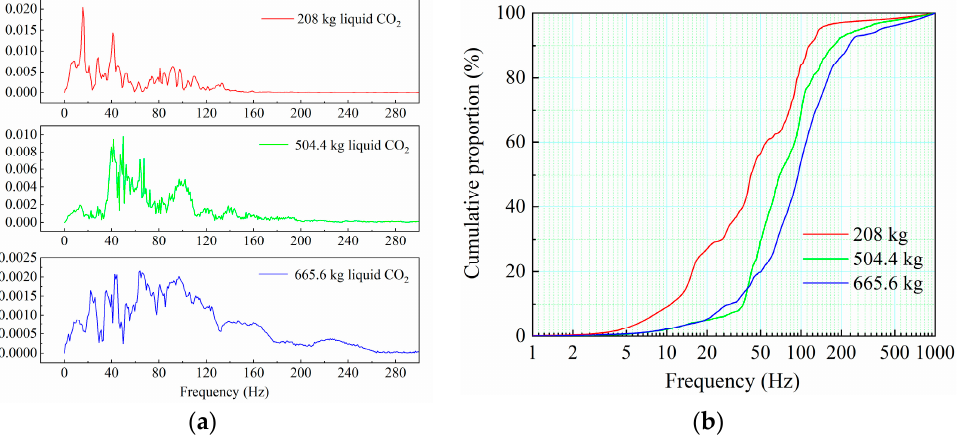
Figure 12. Comparison of vibration velocities under di ff erent fi lling amounts: ( a ) spectrum; ( b ) en- ergy distribution.